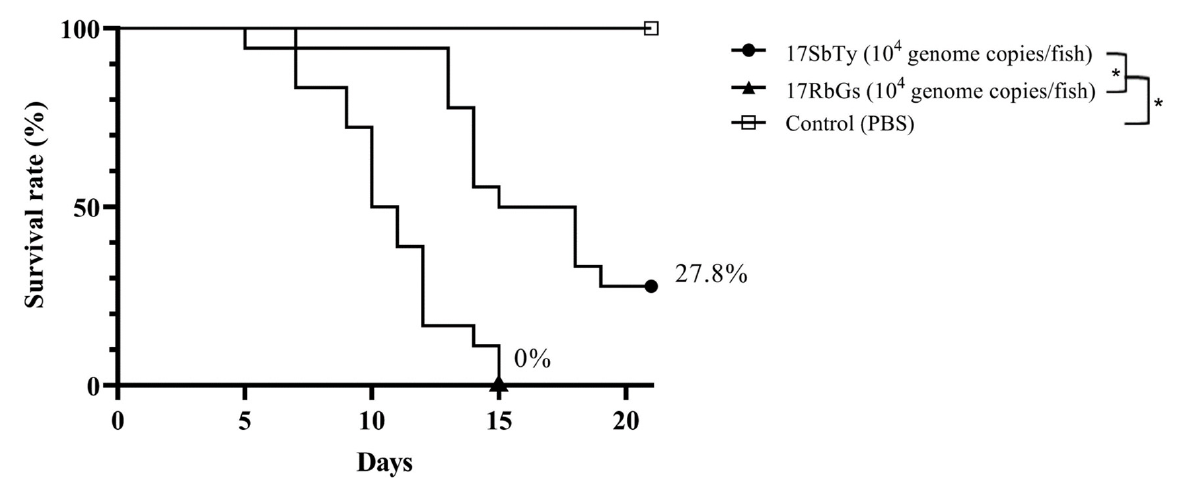
Figure 6. Survival rates (%) of rock breams after intraperitoneal injection with the two RSIV isolates (either 17SbTy or 17RbGs, 10 4 genome copies per fish). Statistical analysis was performed by the log-rank test (* p < 0.05).